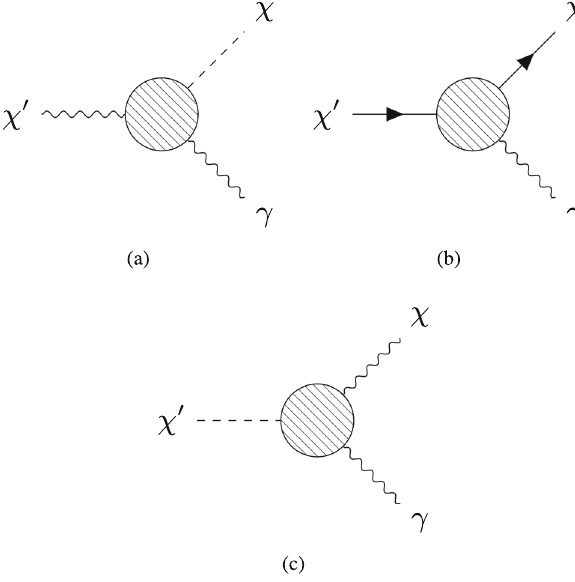
Fig. 3 Diagrammaticrepresentationofaheavyparticle (χ (cid:4) ) thatdecay in hot dark matter (χ) and photon (γ) . Three cases are considered: a χ (cid:4) is spin-1 and χ is a spin-0 particle; b χ (cid:4) and χ are spin-1/2 particles; c χ (cid:4) is spin-0 and χ is a spin-1